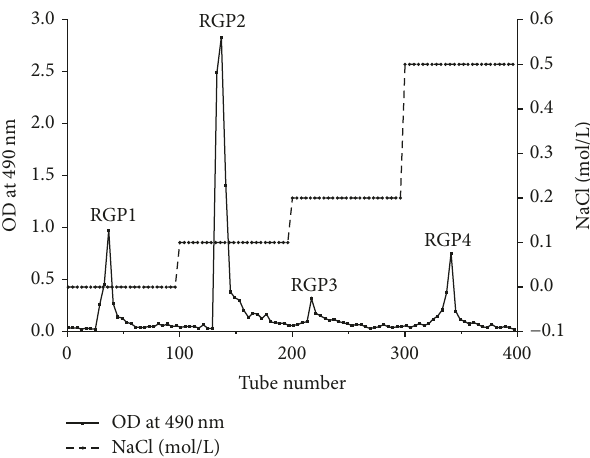
Figure 1: Stepwise elution profile of red ginseng crude polysaccha- rides on DEAE-52 cellulose anion-exchange